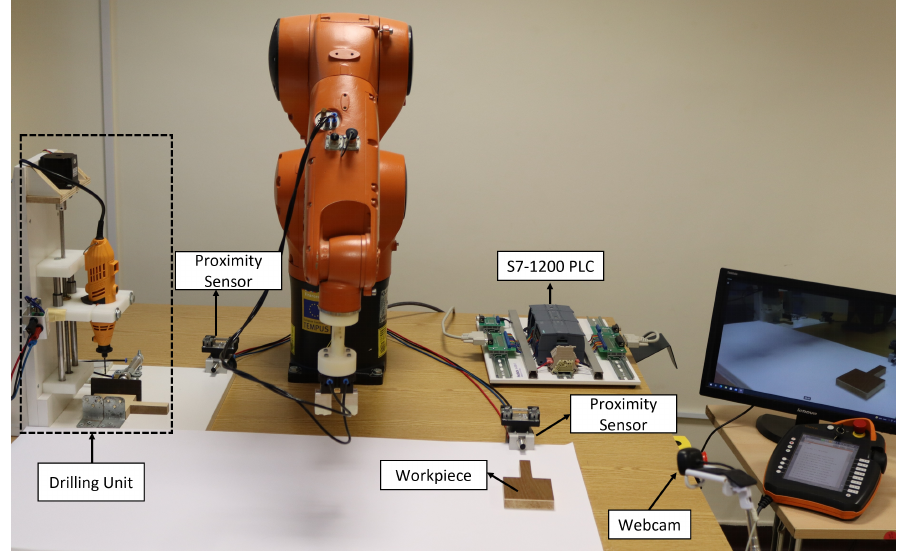
Figure 3. Experimental platform of the proposed smart